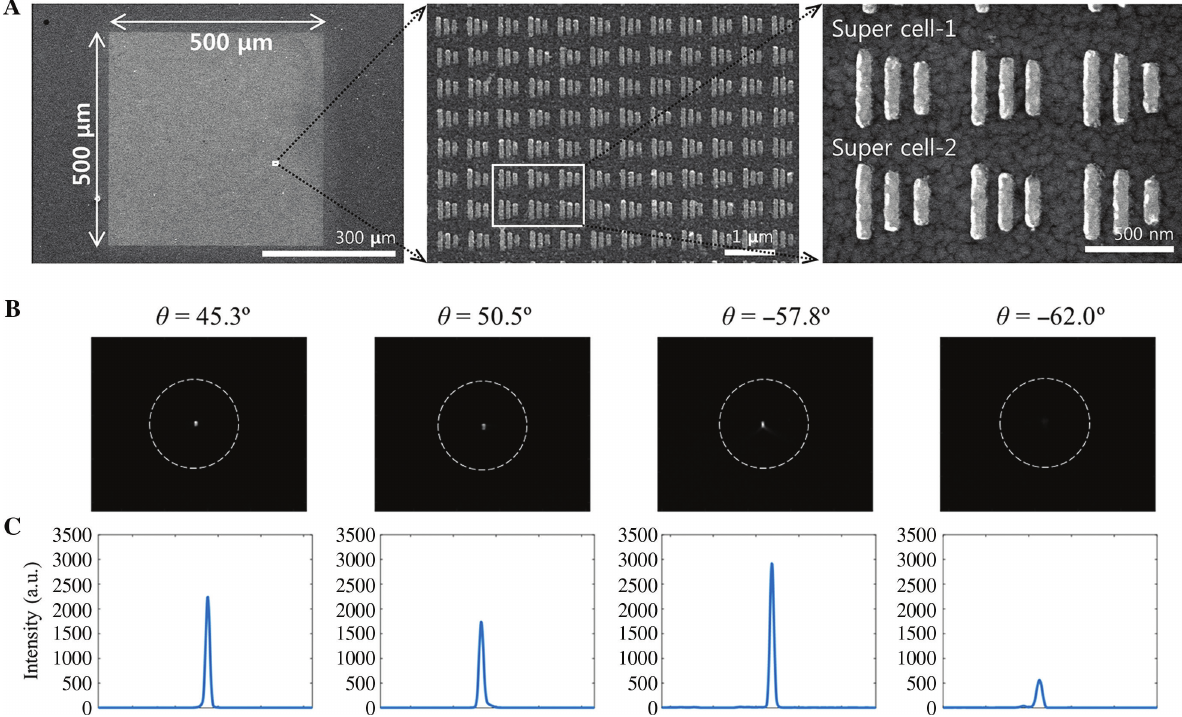
Figure 4: Fabricated metasurface and its experimental results. (A) Field emission-scanning electron microscopy images of the fabricated metasurface samples at different magnifications. The total size of sample is 500 × 500 μ m 2 . (B) Captured CCD images on the Fourier plane for each target wavelength and the measured deflection angles at that time. (C) Intensity corresponding to the above CCD images, which is plotted on an arbitrary unit for efficiency comparison.